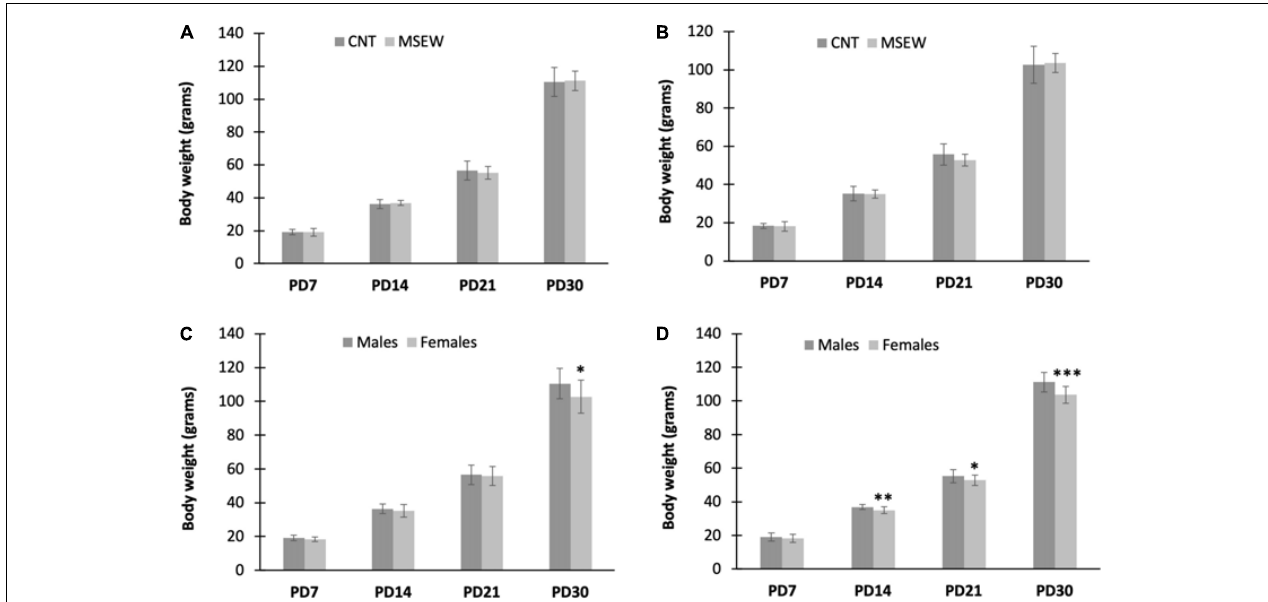
FIGURE 2 | Body weight of rats measured at four postnatal time points. (A) Body weight of male rats in CNT and MSEW groups. (B) Body weight of female rats in CNT and MSEW groups. (C) Body weight of male and female CNT rats. (D) Body weight of male and female MSEW rats. Data were expressed as mean ± SD. n = 20/group.